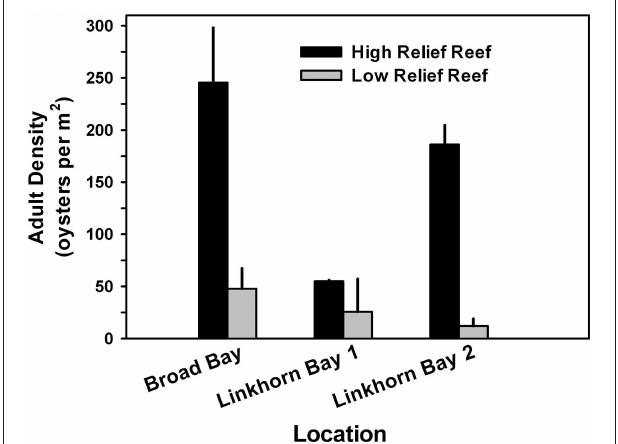
FIGURE 9 | Juvenile oyster density as a function of adult oyster density in each sample. Data from the three areas (Broad Bay, Linkhorn Bay, Lynnhaven River) were normalized to account for differences in recruitment by area. The curve is a non-linear regression fit of the data ( p < 0 . 01 ).